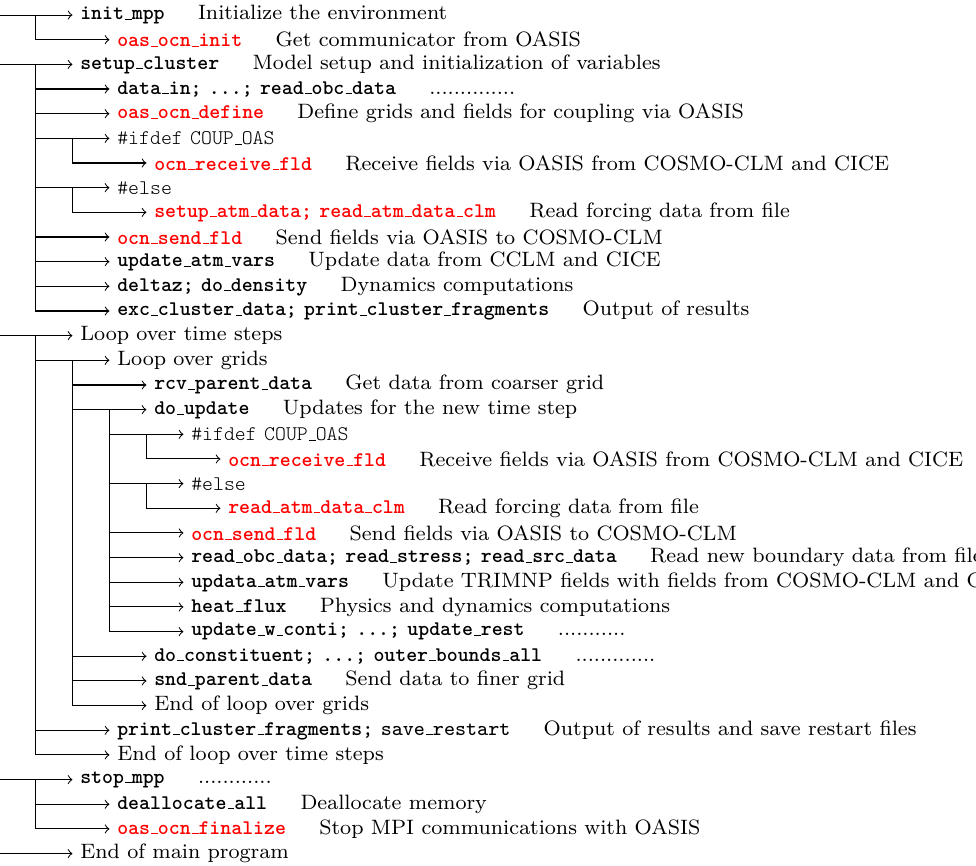
Figure 10. As Fig. 8 but for the TRIMNP ocean